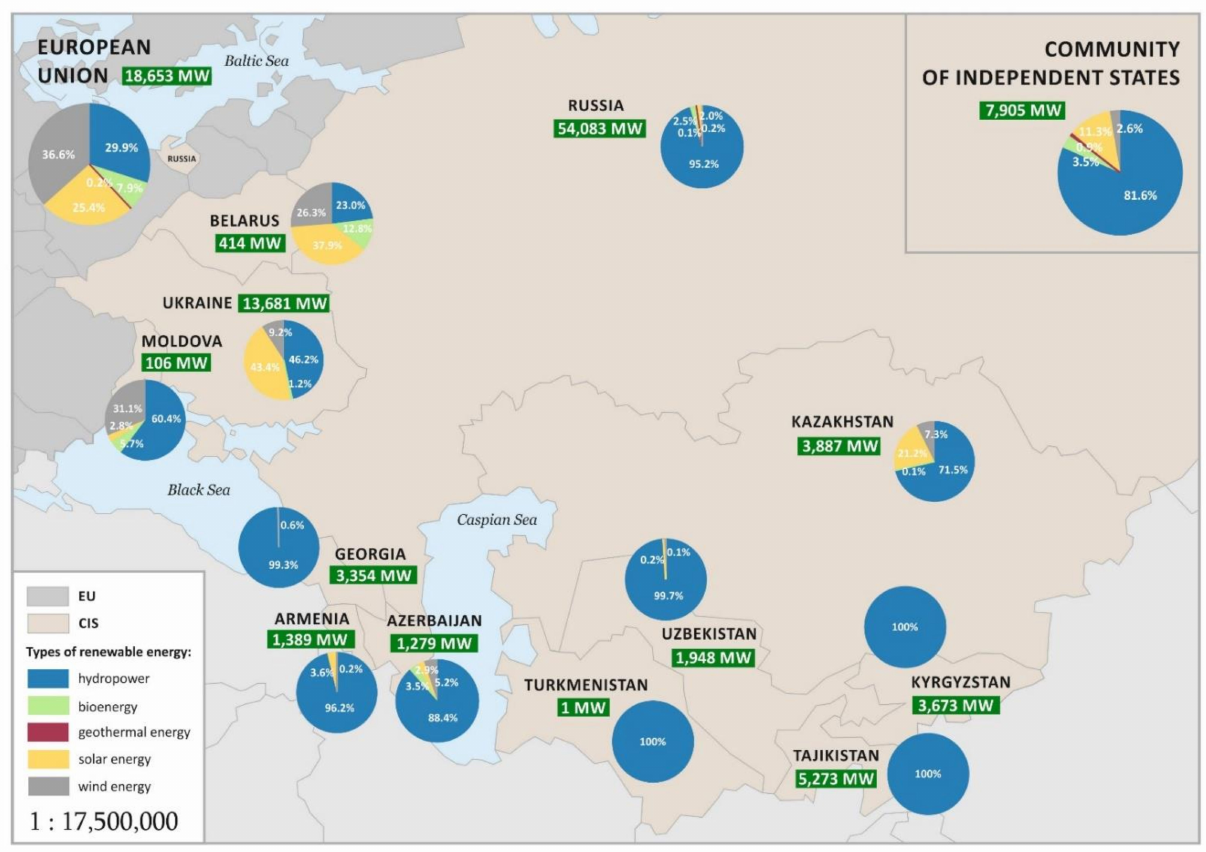
Figure 2. Energy potential of the CIS countries in 2019. Source: Own elaboration based on